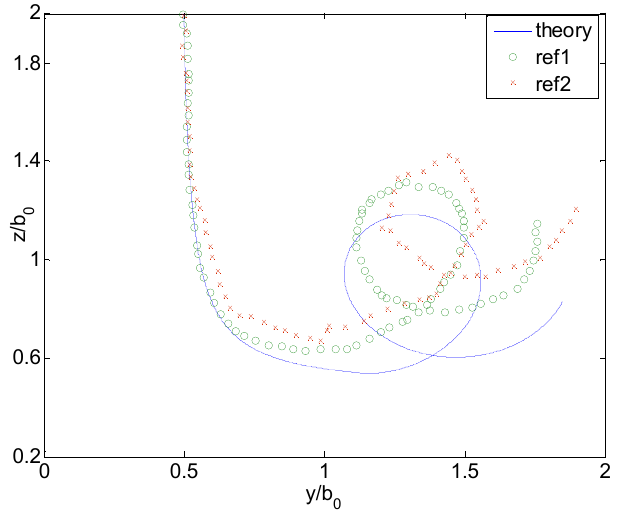
Figure 8. Trajectories of starboard vortex of Thrush 510G in OGE and NGE phases.